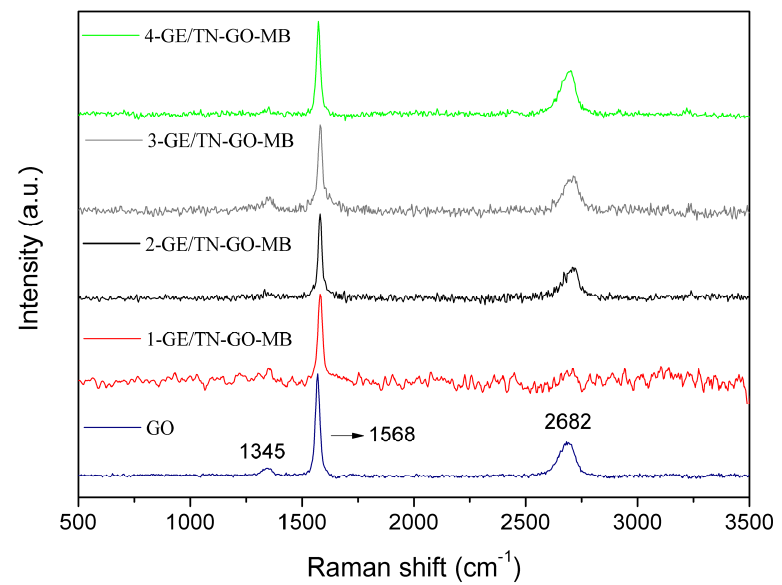
Figure 5. Raman spectra of GO and GE/TN - GO-MB hydrogels with different GO content.